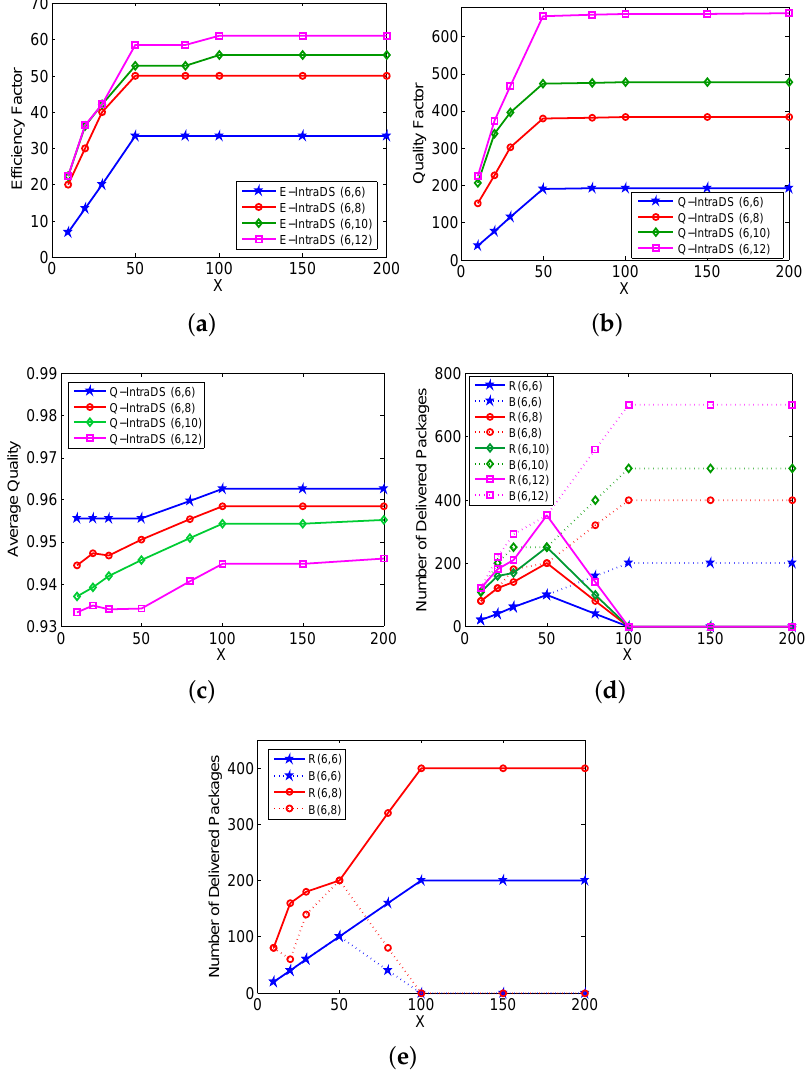
Figure 8. Variation of ( a ) efficiency-factor, ( b ) quality-factor, ( c ) average delivered quality and ( d , e ) number of delivered packages, with different X . In the legends, R ( a , b ) and B ( a , b ) denote raspberries and broccoli, and a and b are T min and T max , respectively. Q-IntraDS, quality